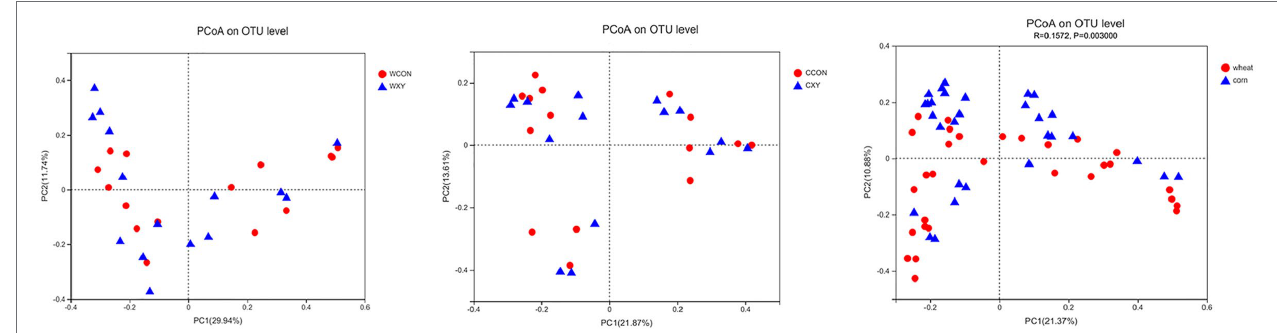
FIGURE 4 | Principal coordinate analysis (PCoA) representing similarity of cecal microbiota in broilers fed corn- or wheat-based diets. The PCoA was performed by using Weighted UniFrac distance to determine β -diversity of bacterial communities between different groups. No distinct clustering due to xylanase supplementation was denoted (WCON vs. WXY; CCON vs. CXY). However, a less pronounced but distinct variation was observed in broilers fed wheat- or corn-based diets (ANOSIM, R = 0.1572, P = 0.003). Wheat-soybean basal diet (WCON); wheat-soybean basal diet with 4,000 U/kg xylanase (WXY); corn-soybean basal diet (CCON);